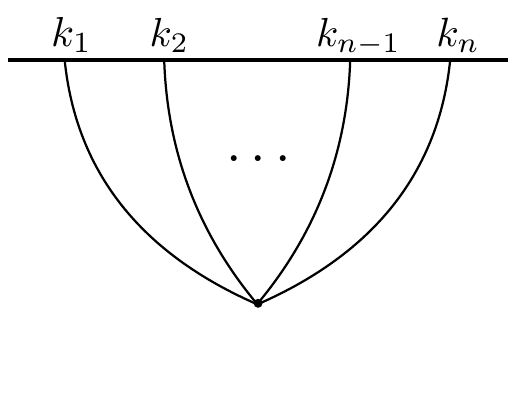
Figure 1. Contact diagram for n external